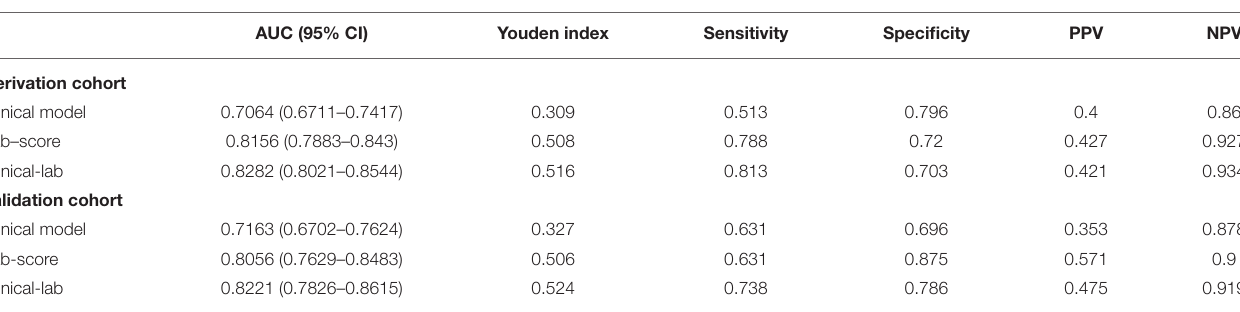
TABLE 2 | Accuracy of the three models for predicting